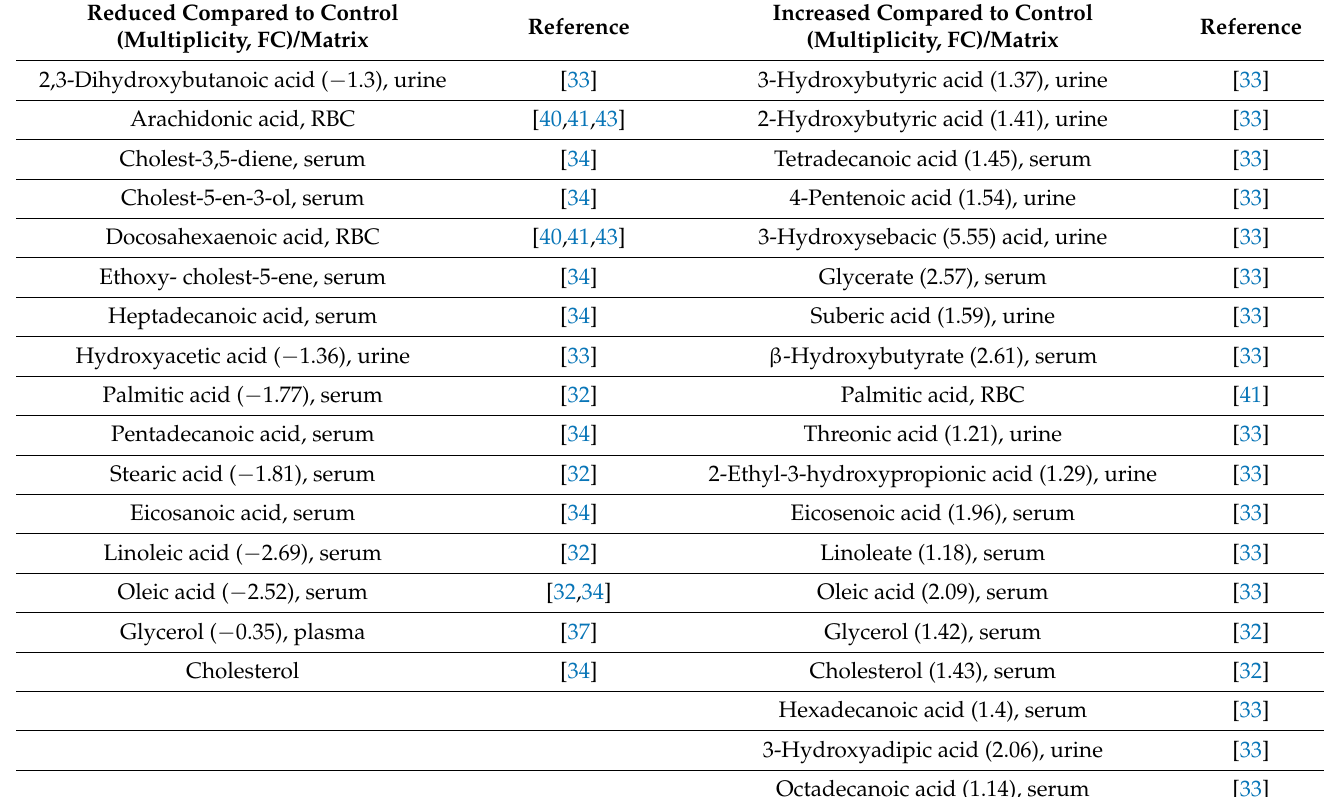
Table 4. Differentiating between schizophrenic patients and healthy controls lipid and fatty acids